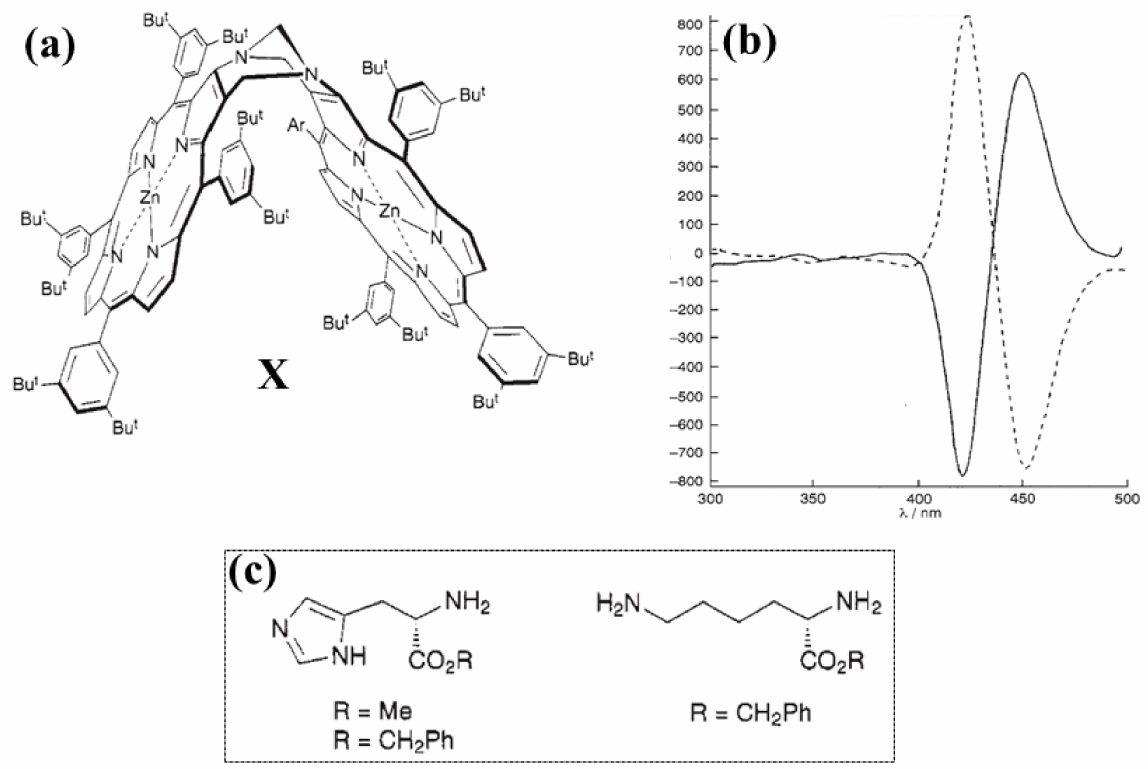
Figure 7. ( a ) Structure of the chiral bisporphyrin X ; ( b ) CD spectra of the enantiomers of Zn(II) bis-porphyrin X in chloroform; ( c ) Structures of histidine methyl and benzyl esters (on the left) and lysine benzyl ester (on the right). Adapted with permission from reference [65]; published by Royal Society of Chemistry